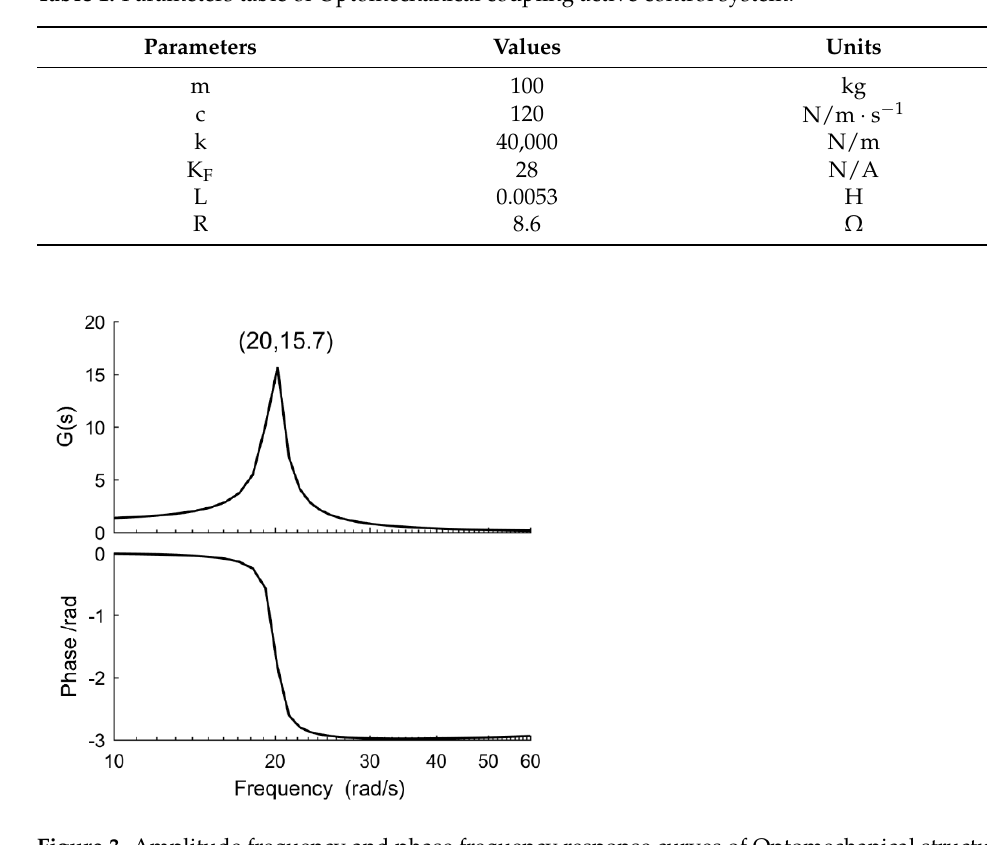
Figure 2. Triaxial vibration response signal of spatial filter support truss. Table 1. Parameters table of Optomechanical coupling active control system.